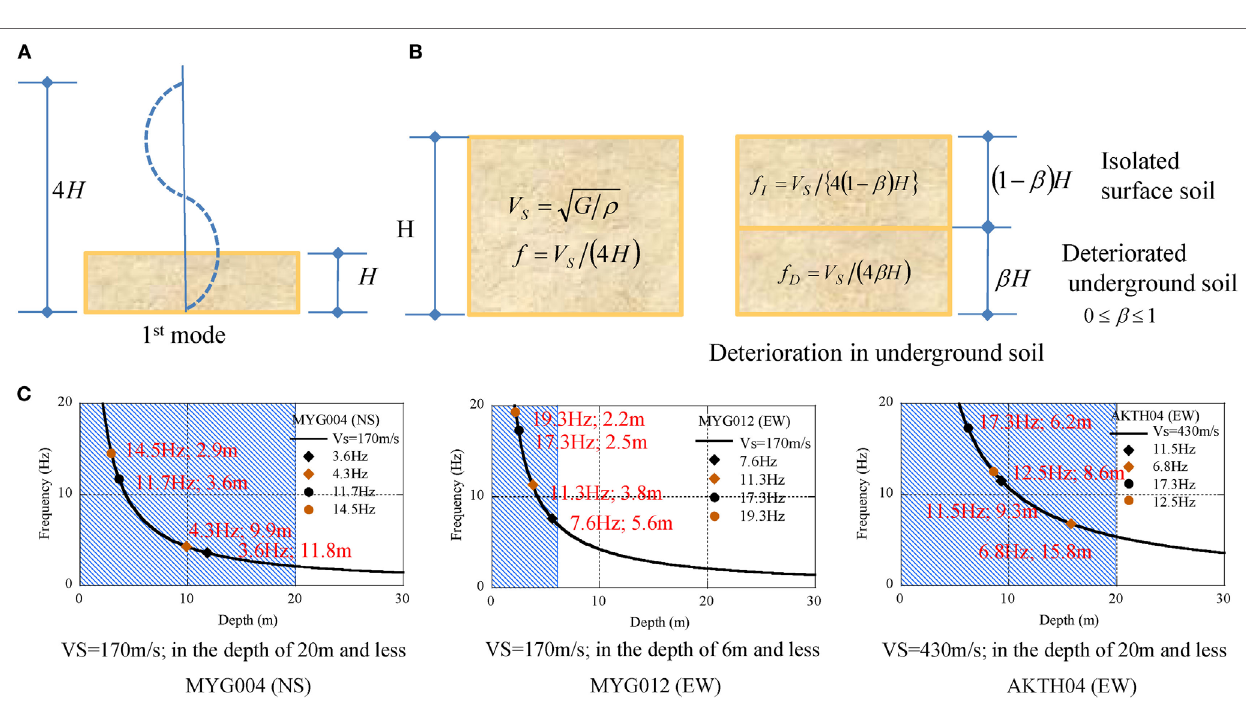
the soil depth and the frequency is illustrated in Figure 13A . The derived depth of isolated surface soil is plotted by the marks of circle and square, and the depth extension with V s of surface soil is shaded in Figure 13C .